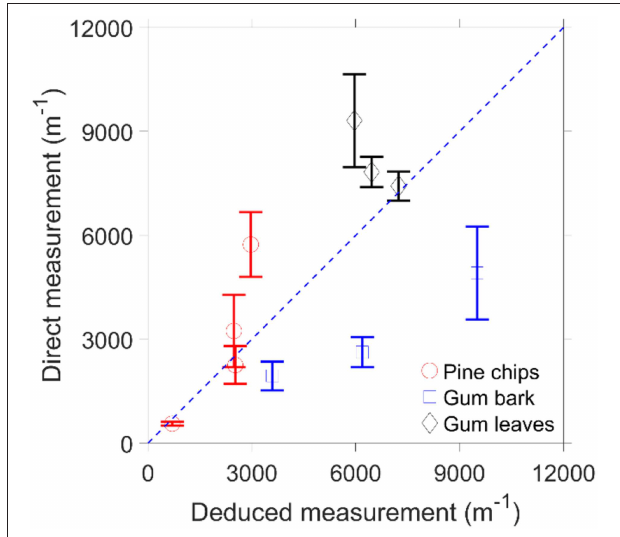
FIGURE 8 | Comparison of the direct measurement and the measurement through pressure gradient of the specific area under the different particle